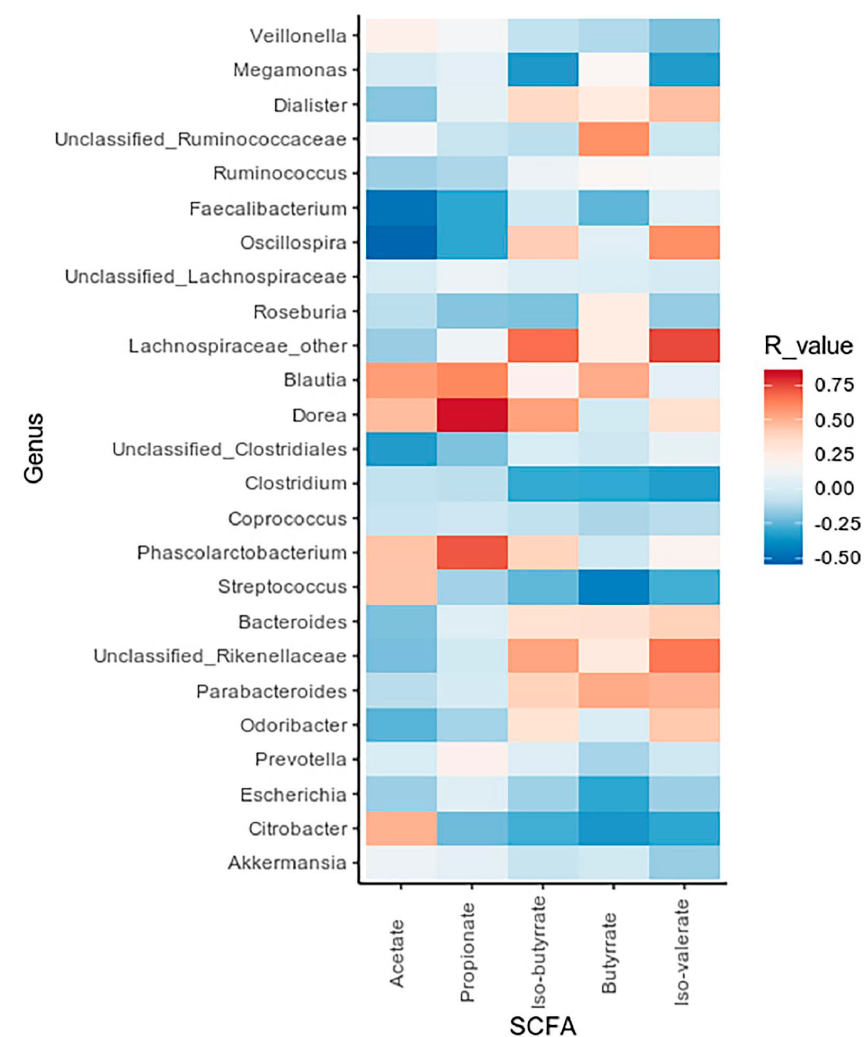
Figure 3. Correlation between SCFA values and bacterial genera. Heatmap showing Spearman’s correlations between the most abundant microbial genera and SCFA concentrations. Red tiles indicate a positive correlation, blue tiles a negative one for both HC and GSD groups.